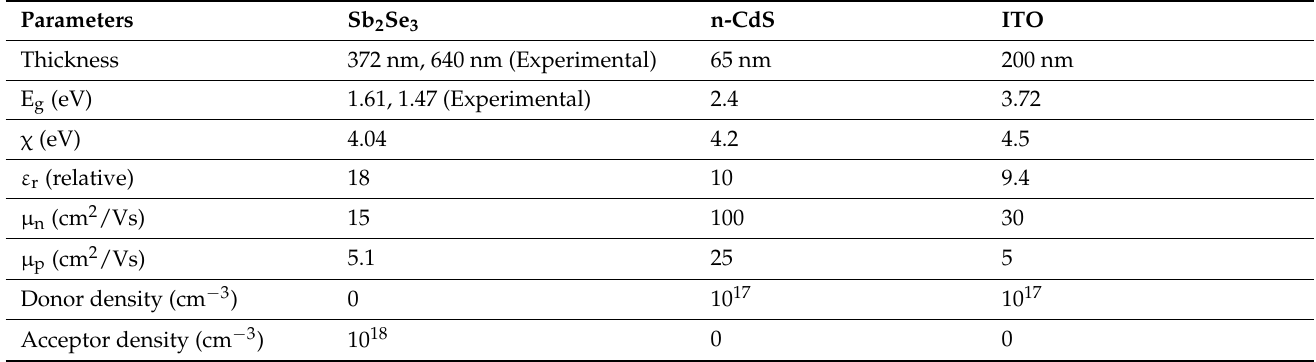
Table 1. Simulation parameters for Sb 2 Se 3 -/CdS-/ITO-based solar